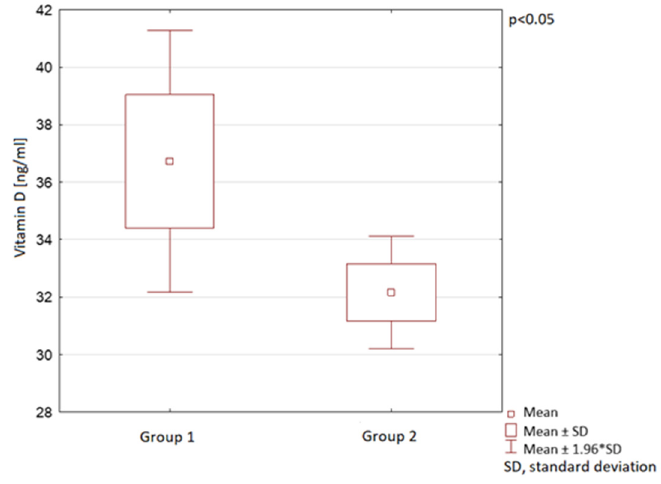
Figure 8. Vitamin D serum levels in autumn in children in the compared groups.